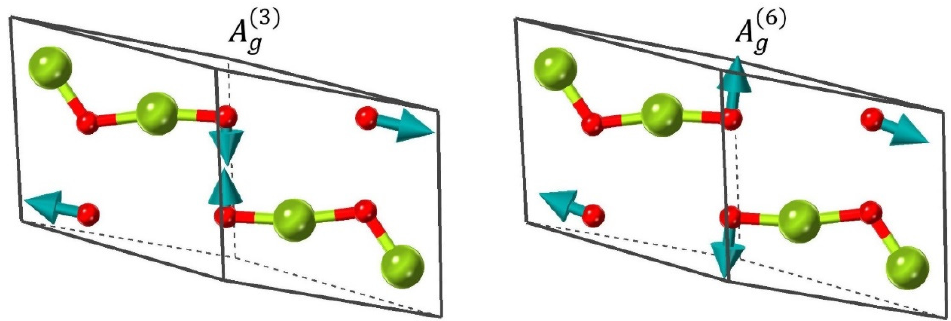
Figure 6. Directions and relative amplitudes of oscillations of β -Ga 2 O 3 atoms, as calculated in the DFT framework for the two main lines, A g and A g , of the Raman spectrum. Only one primitive cell is shown; z-axis is up.